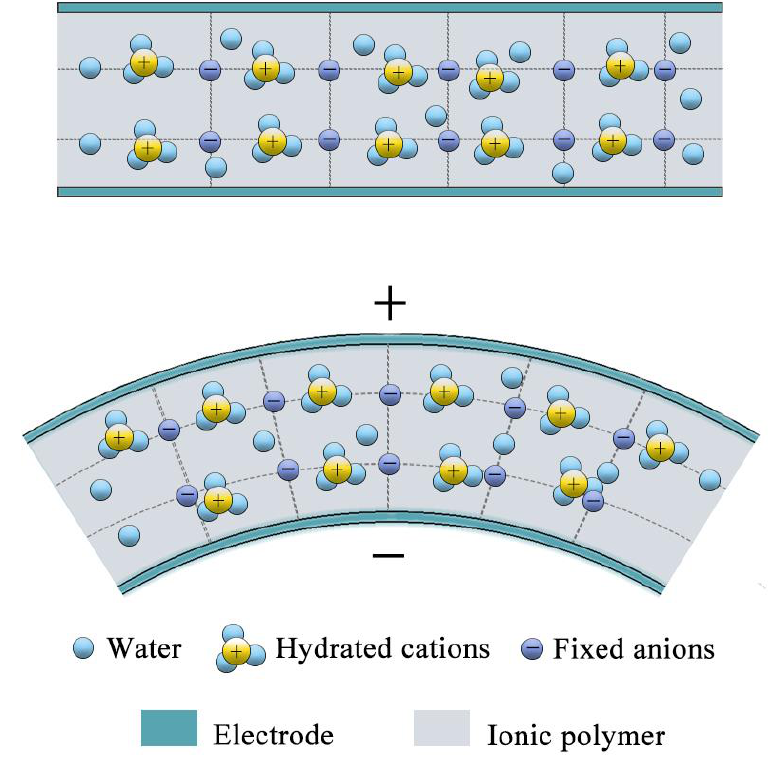
Figure 1. Ionic polymer-metal composite (IPMC) sensing under a bending deformation.